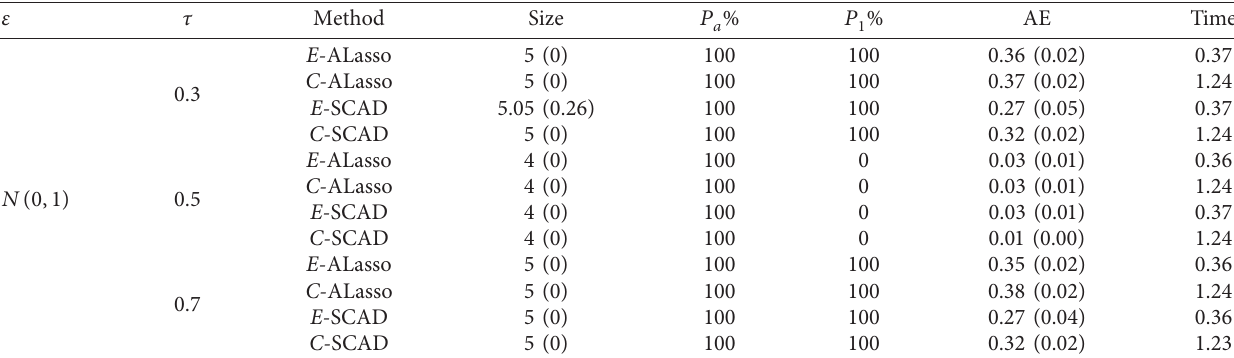
Table 2: Simulation results for k � 50 , n � 100 , p � 300 , and N � nk